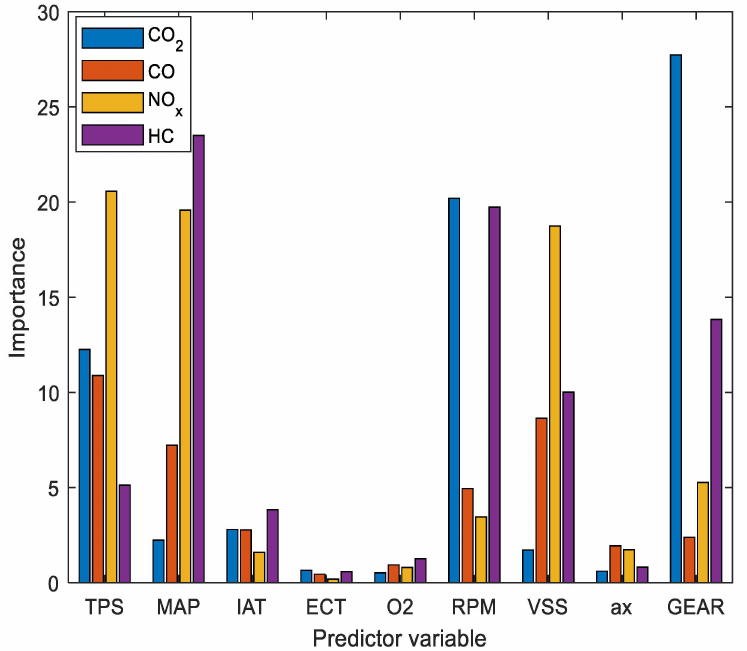
Figure 7. Importance of predictors in instantaneous pollutant